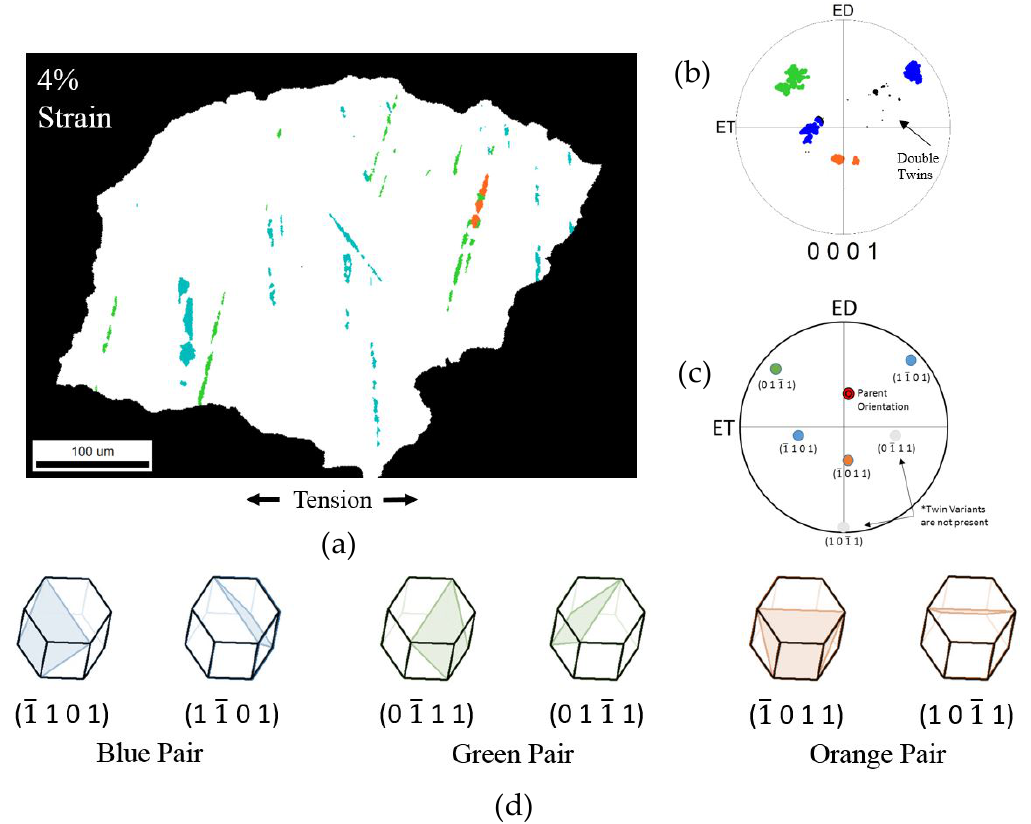
Figure 18. Characterization of { 1011 } contraction twins at ( a ) 4% strain revealing continuous nucleation of new twin variants. The twins were individually selected to be partitioned from the parent grain. The texture of the partitioned twins is shown in part ( b ). Double twins are found among the partitioned twins. The idealized texture of { 1011 } contraction twins is shown in part ( c ). Not all twin variants are present, but they are representatives of each twin pair. The contraction twin variants are characterized by their respective color pair highlighted in the parent grain ( a ), pole figures ( b , c ), and crystal lattice ( d